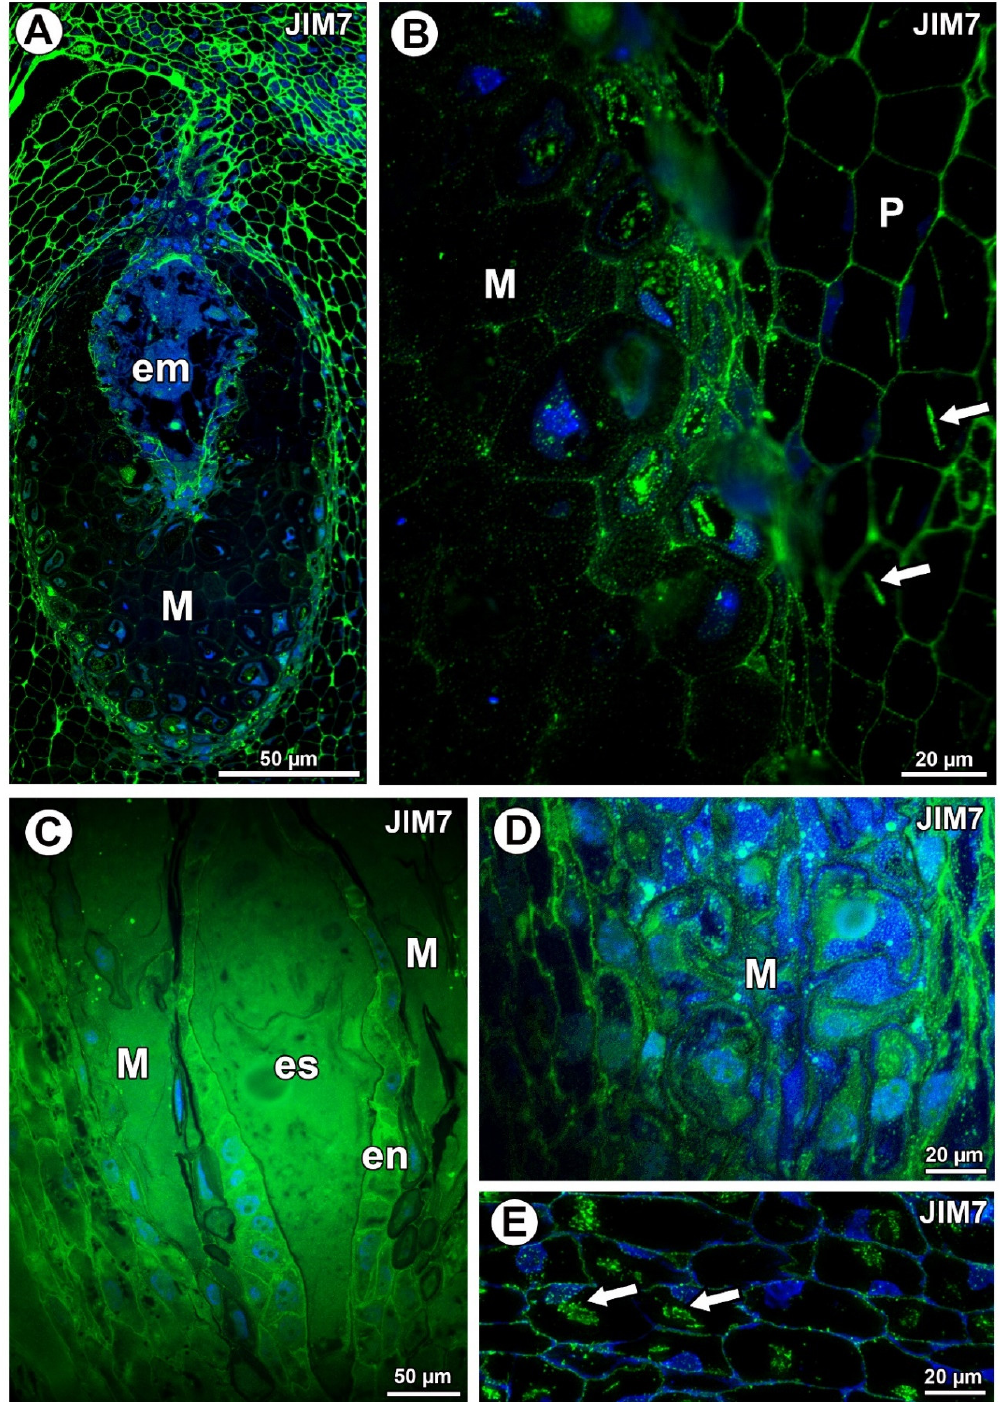
Figure 2. Pectin (JIM7) detection. ( A ) Distribution of the JIM7 antibody in the young seed of Taraxacum officinale ; embryo (em) and mucilage cells of integument periendothelial tissue (M). ( B ) Pectin (JIM5) detection in mucilage cells (M) and parenchyma cells (P) in T. officinale ; note the association between pectin and calcium oxalate crystals (arrows). ( C ) Pectin detection in ovule of Pilosella officinarum ; embryo sac (es), mucilage (M), and endothelium (en). ( D ) Pectin detection in mucilage cells of P. officinarum . ( E ) Pectin association with calcium oxalate crystals (arrows) in ovule parenchyma cells of P. officinarum .